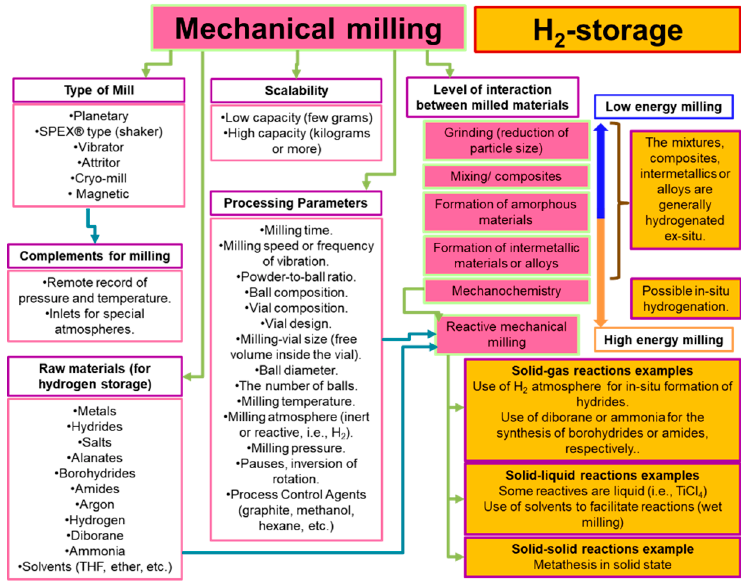
Figure 2. Mechanical milling main concepts.